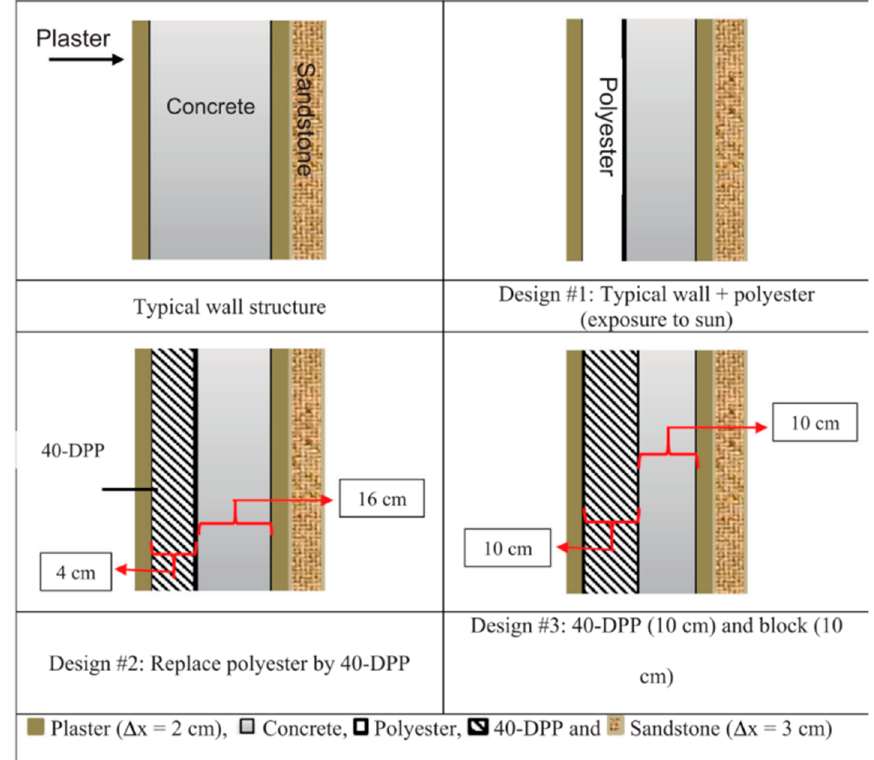
Figure 11. Components and designs of a wall structure with PLA and date pit powder [171]. Reprinted with permission from ref. [168]. Copyright 2020 Elsevier